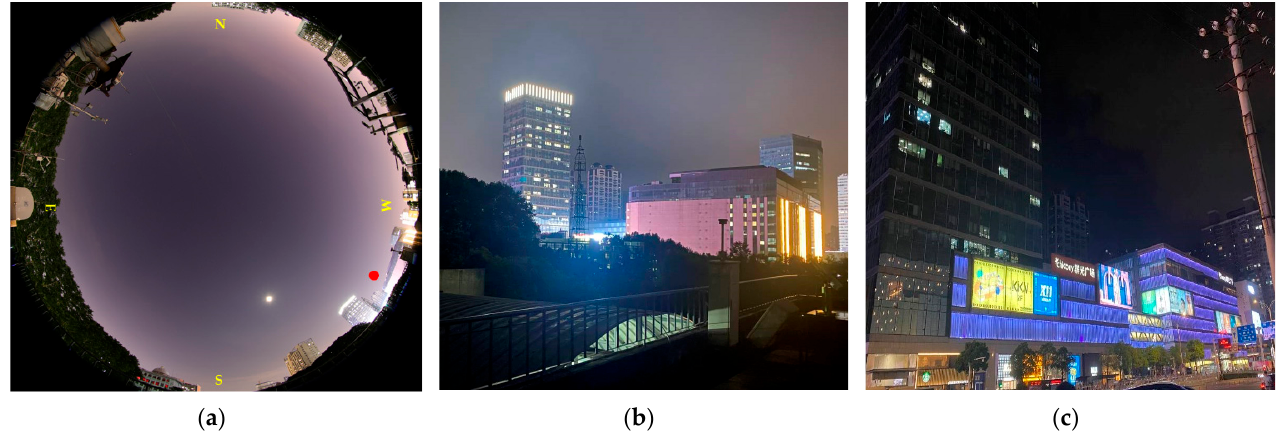
Figure 2. The night-time skyglow and surrounding NTL sources. ( a ) The image of the complete night-time skyglow induced by the moon and urban NTL with a digital camera with a fisheye lens. The red dot demonstrates the direction of the Jiedaokou commercial district; ( b ) The image of the Jiedaokou commercial district from the observation site; ( c ) The main decorative lights in the Jiedaokou commercial district.